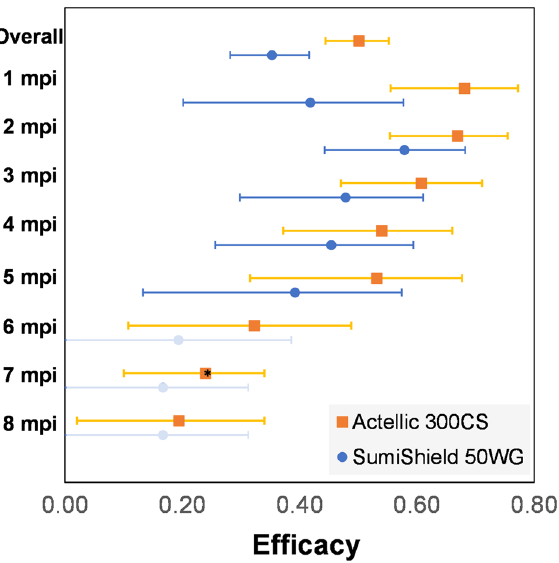
Figure 3. Estimated intervention efficacy. Expressed as the proportional reduction compared to the control arm in reducing Ae. aegypti density per house (squares and circles) and the predicted 95%CI of such estimates (error bars). Efficacy was calculated for the overall effect (during the 8 months post-intervention, mpi) and for each mpi. Solid colors show significant efficacy compared to the control, grayed colors non-significant associations and * marginal (P < 0.1) associations (see Table